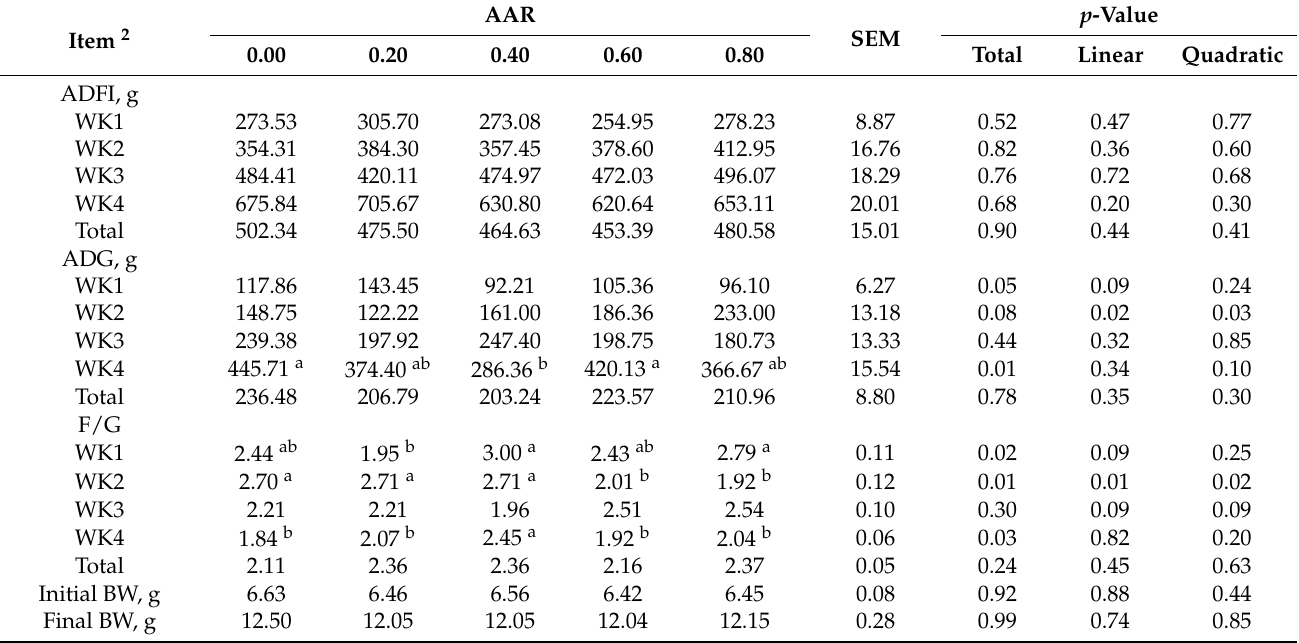
Table 2. Influence of diet with different amylose–amylopectin ratio on the growth performance of weaned piglets 1